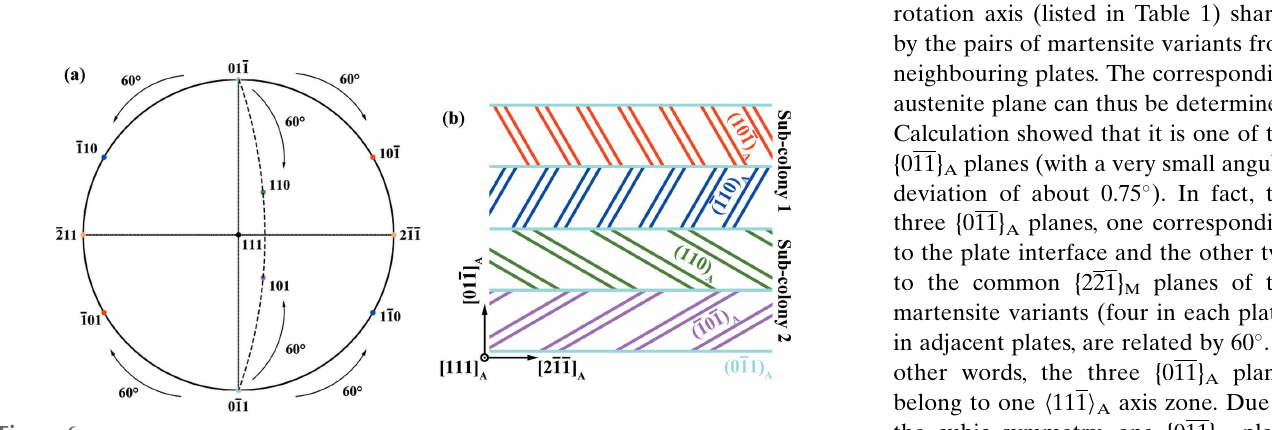
Figure 6 ( a ) (111) A standard stereographic projection. The (011) A , (101) A and (110) A planes that are located on the circumference belong to the [111] A axis zone, whereas the (011) A , (110) A and (101) A planes that are located on the dashed arc line belong to the [ 111] A axis zone. ( b ) A microstructural schema of the corresponding plate colony containing two pairs of compatible plates, one being related to the (011) A , (101) A and (110) A group and the other to the (011) A , (110) A and (101) A